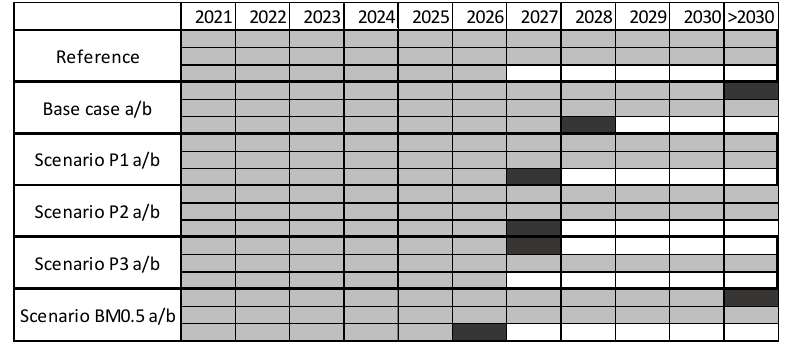
Figure 1. Availability of allowances from the reserve. light grey: allowances available from the reserve in both scenarios; dark grey: allowances available from the reserve in one of two scenarios; white: not sufficient allowances available from the reserve in both scenarios; three rows per scenario relate to: production trends, +5%, +10% production.